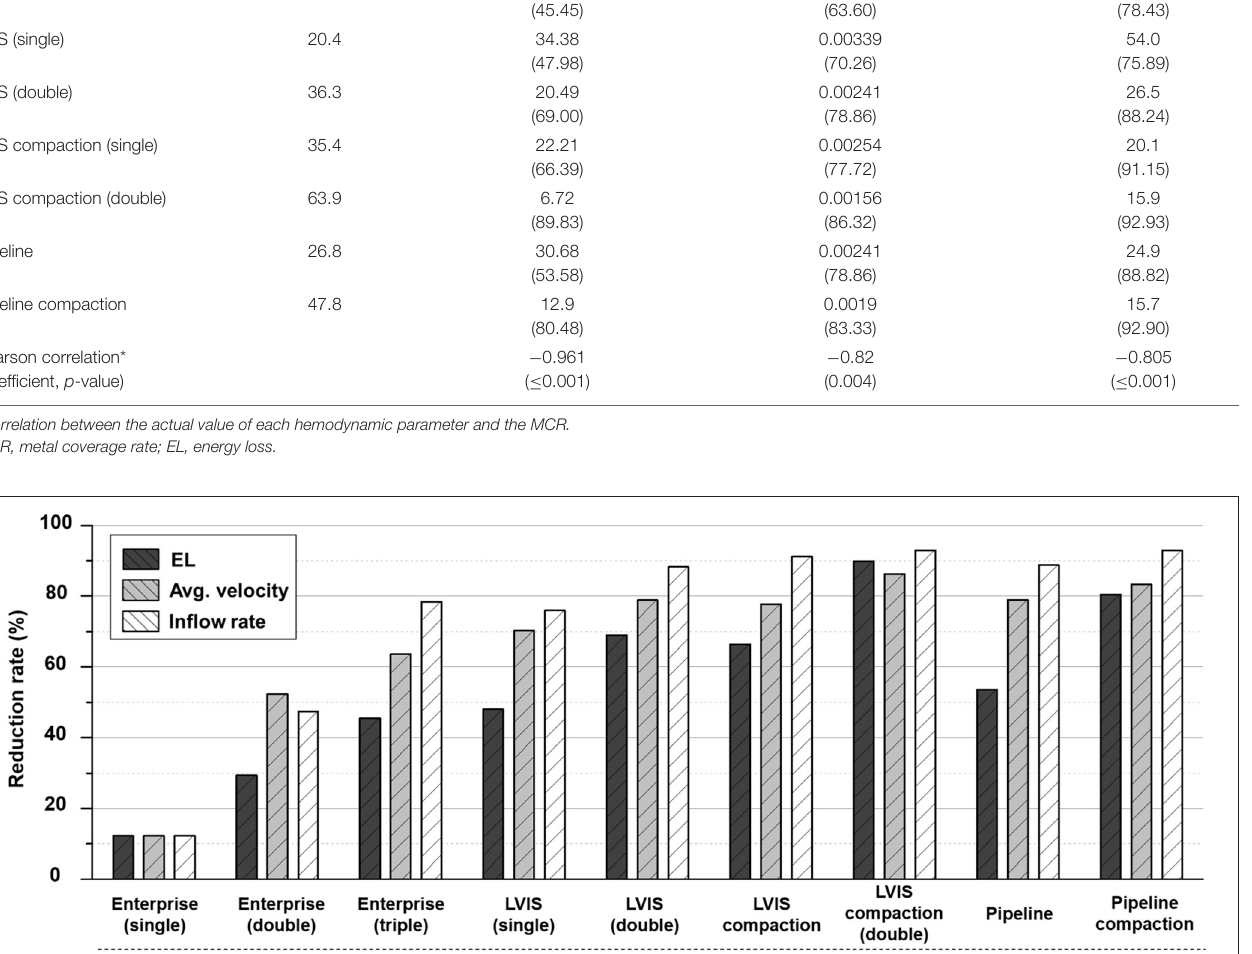
increased accordingly, and the correlation was statistically significant ( Figure 2